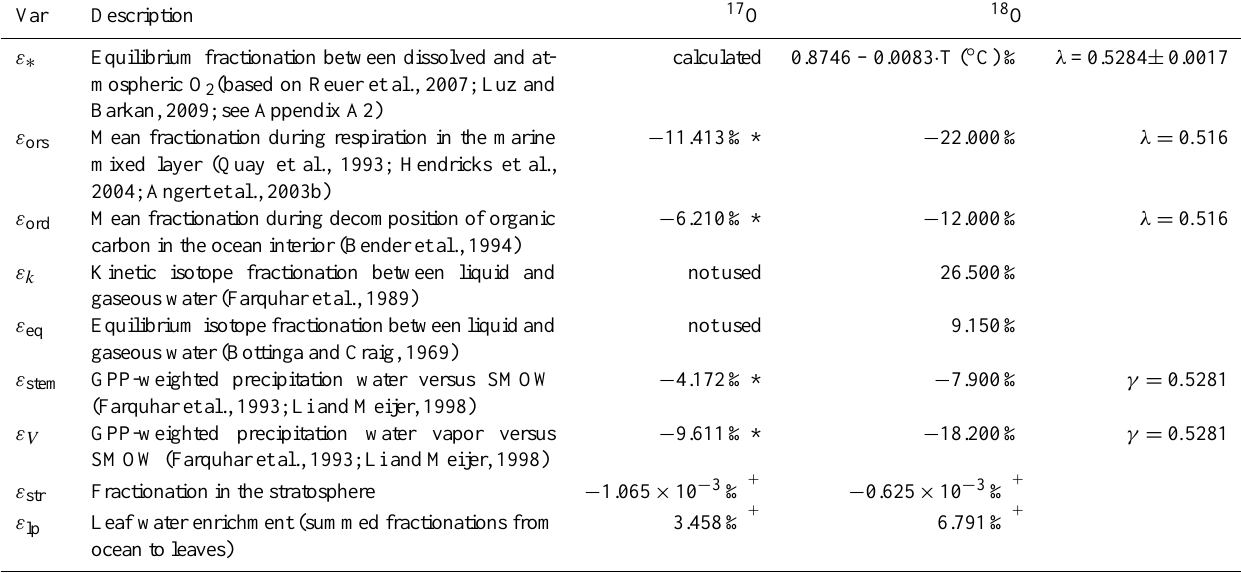
Table 2. Model parameters: